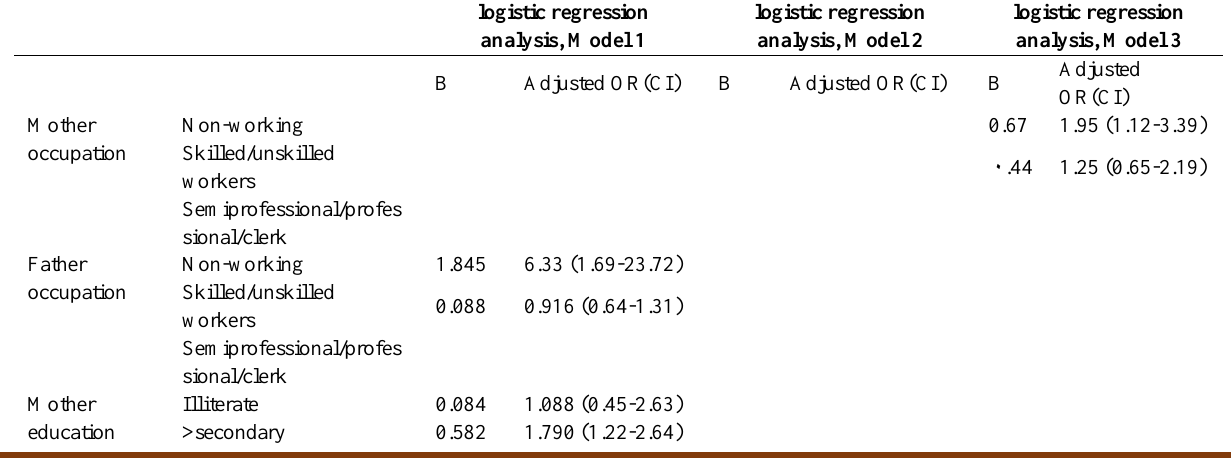
Table 3 : Crude and adjusted OR of different factors associated with moderate/marked body shape concern measured by Body shape questionnaire